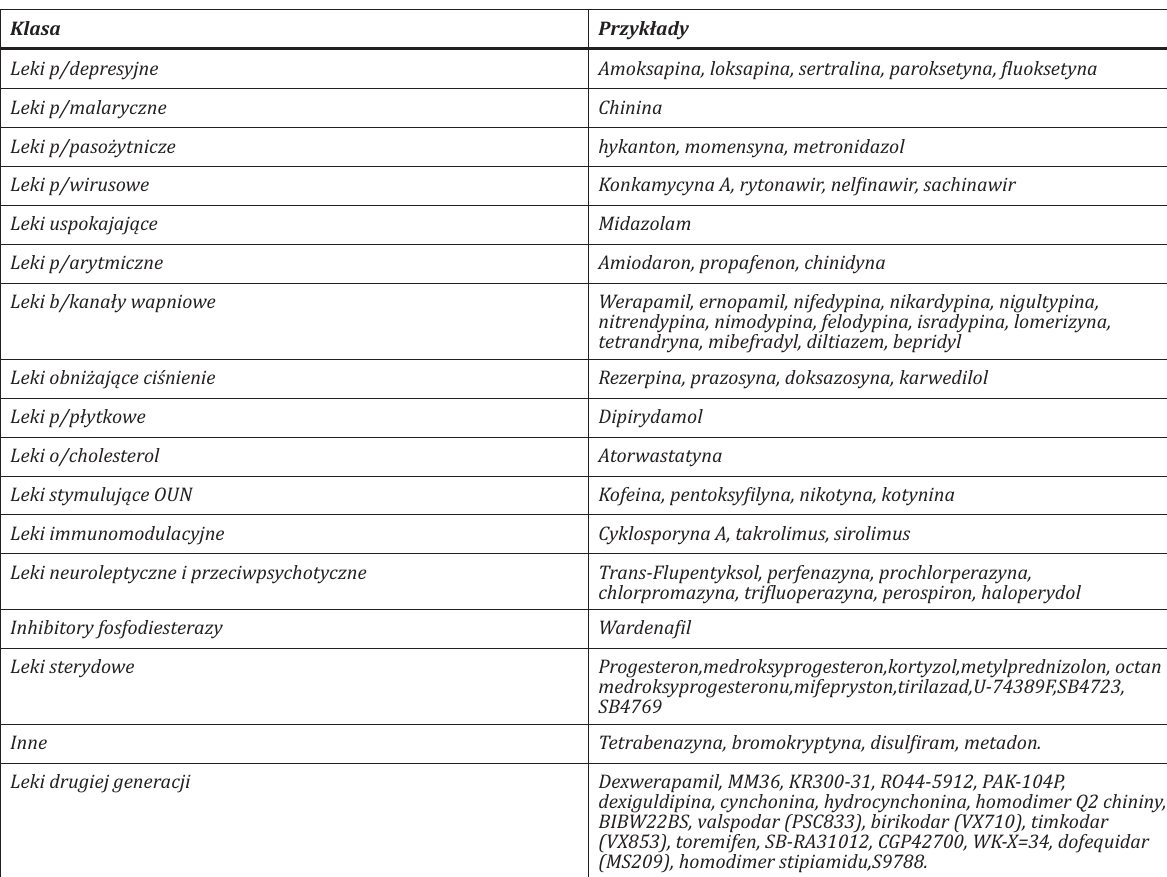
Biotransformacja citalopramu do demetylcitalopramu